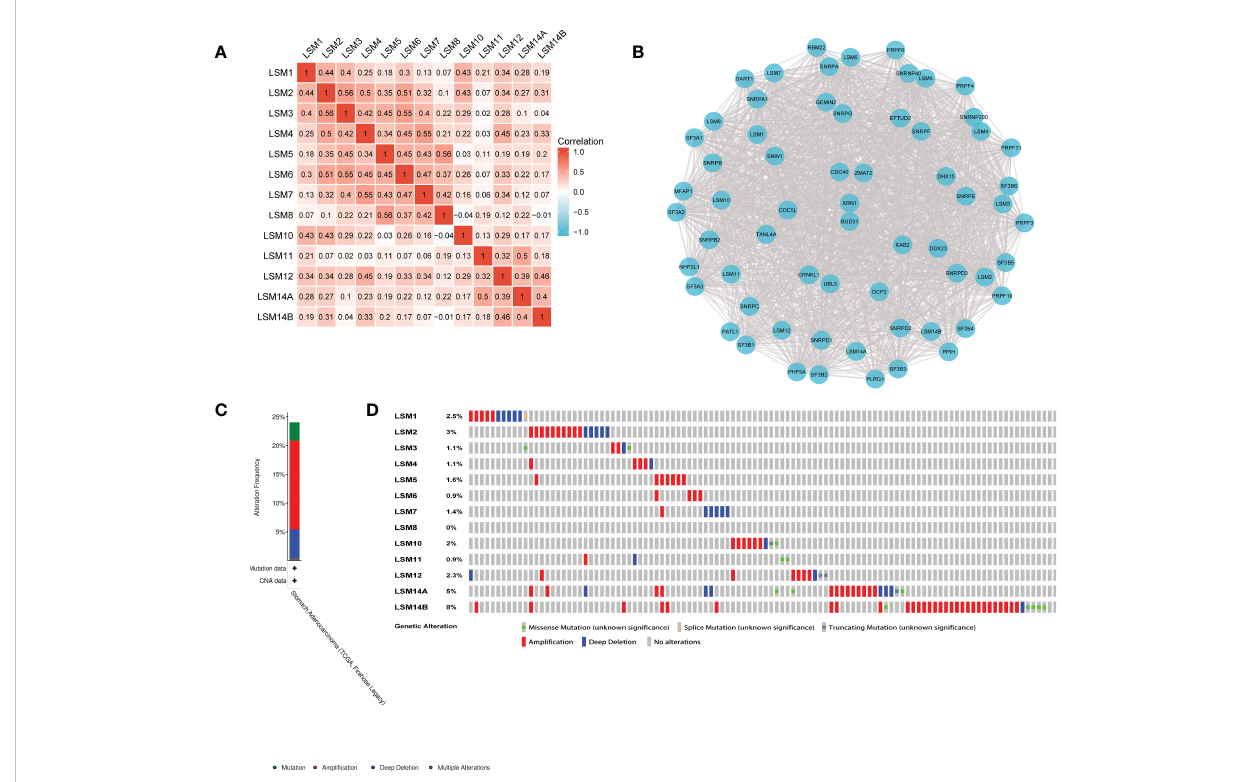
FIGURE 2 Heatmap, network and genetic mutations of LSM proteins. (A) the correlation among the LSM members by the Pearson correlation analysis from TCGA database. (B) Network comprising LSM1-14B and their most closely associated genes by STRING and Cytoscape analysis. (C, D) Genetic mutation analysis of LSM proteins by cBioPortal.